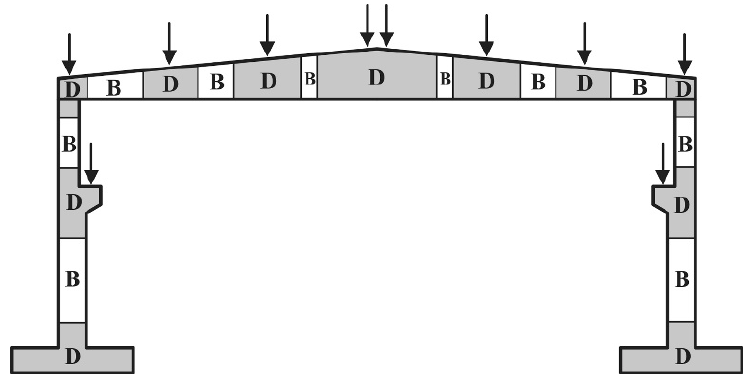
Figure 1. B and D regions.